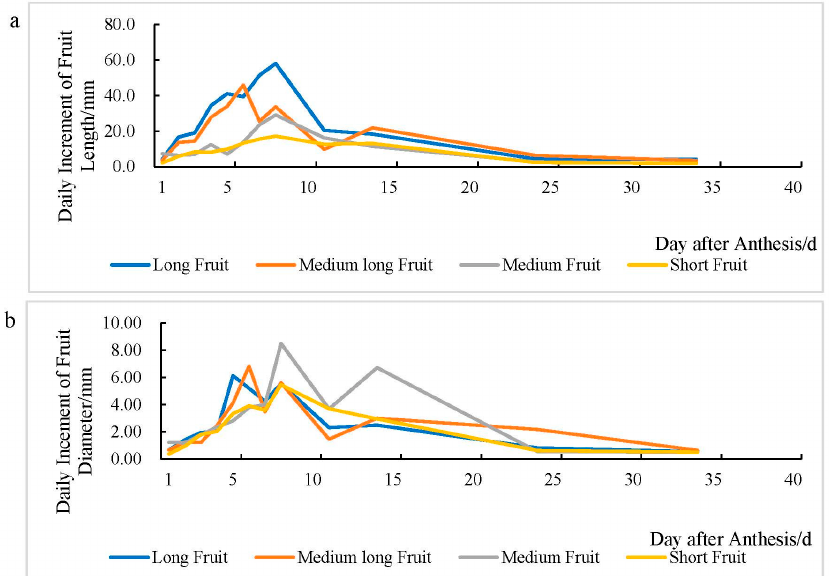
Figure 4. Daily growth of fruit length ( a ) and fruit diameter ( b ) in four types of cucumber fruits during fruit development process.